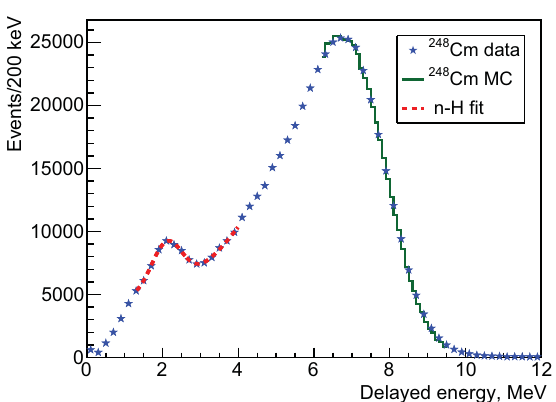
Figure 1. Energy spectrum of the delayed signals measured with the 248 Cm neutron source. The dashed curve shows the fit of the n-H peak. The histogram is the MC prediction for the n-Gd peak.